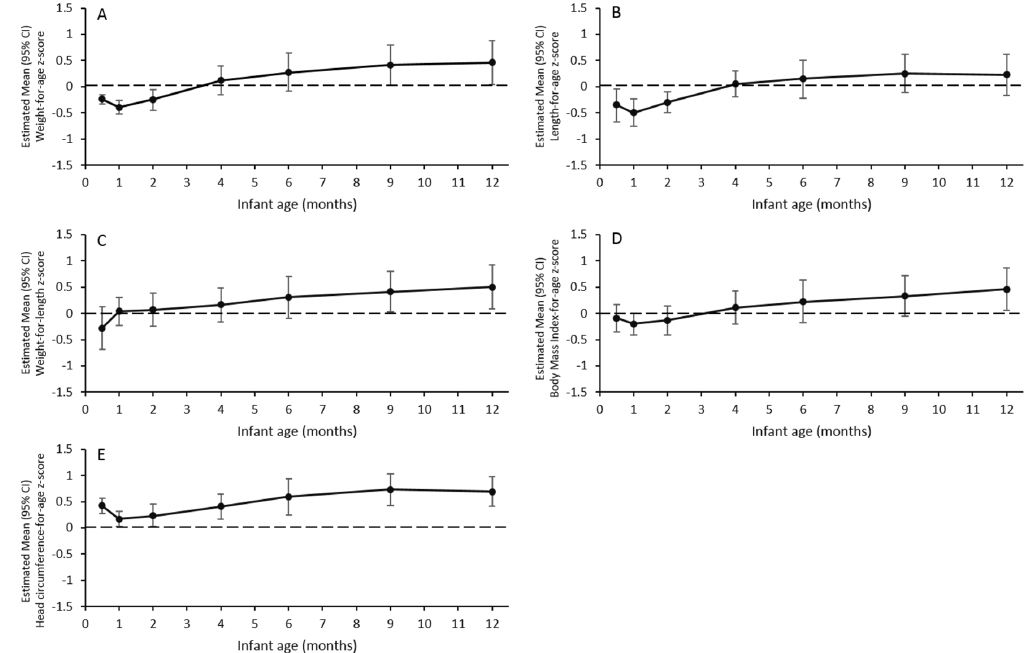
Figure 2. Anthropometric z ‐ scores compared to the WHO 2006 Child Growth Standards. Data presented are estimated means (95% CIs) of z ‐ scores for weight ‐ for ‐ age ( A ), length ‐ for ‐ age ( B ), weight ‐ for ‐ length ( C ), body mass index ‐ for ‐ age ( D ), and head circumference ‐ for age ( E ) calculated from linear repeated mixed models. Fixed effects included corresponding birth z ‐ scores, infant sex, study center, visits, smoking status of the mother (if significant at 0.1 level), and visits × infant sex. n = 17, 29, 29, 29, 28, 28, and 27, at age 0.5, 1, 2, 4, 6, 9, and 12 months, respectively.